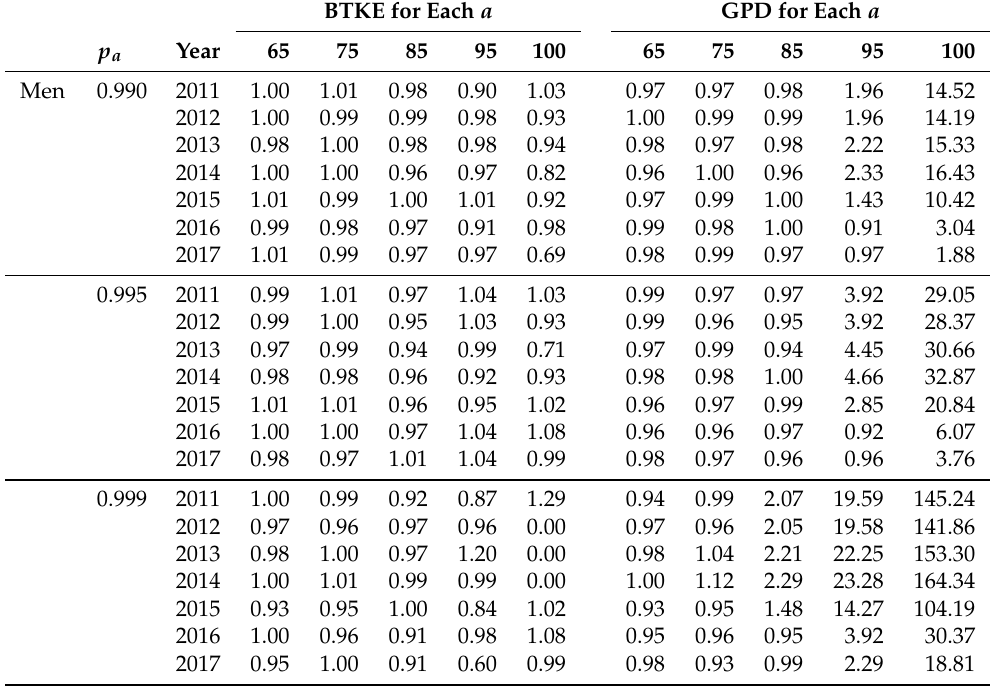
Table A4. Quotients between empirical and theoretical ( 1 − p a ) significance levels of estimated CQ p for the age-at-death of the population aged over 65 in Spain, separately for men and women, a from 2011 to 2017, using a Beta Transformed Kernel Estimator (BTKE) or a Generalized Pareto Distribution (GPD). BTKE for Each